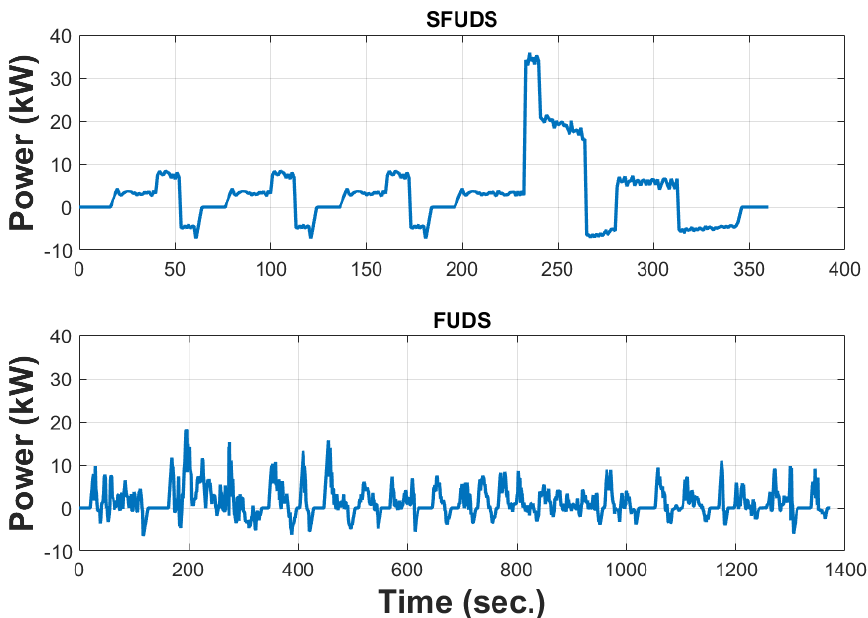
Figure 11. NEDC (top) and WLTP (bottom).